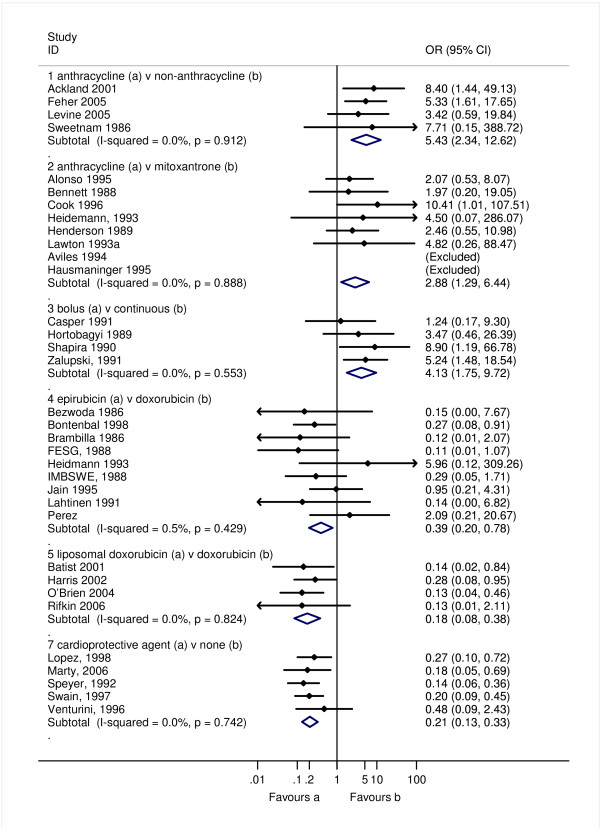
Clinical cardiotoxicity defined as incidence of CHF in RCTs comparing different treatment regimens. The open diamond represents the pooled Peto Odds Ratio and 95% confidence interval (CI) for each treatment comparison. I-squared represents the proportion of variability between studies in excess of that expected due to chance, and p = probability that differences between study estimates are due to chance.